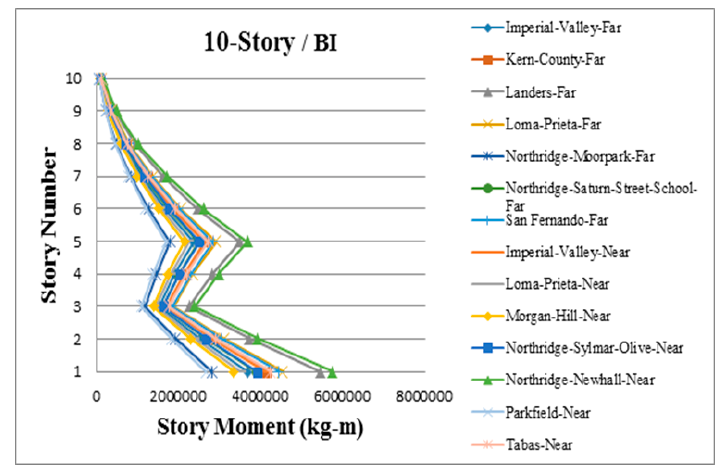
Figure 9. Peak story moments for 10-story base-isolated building.